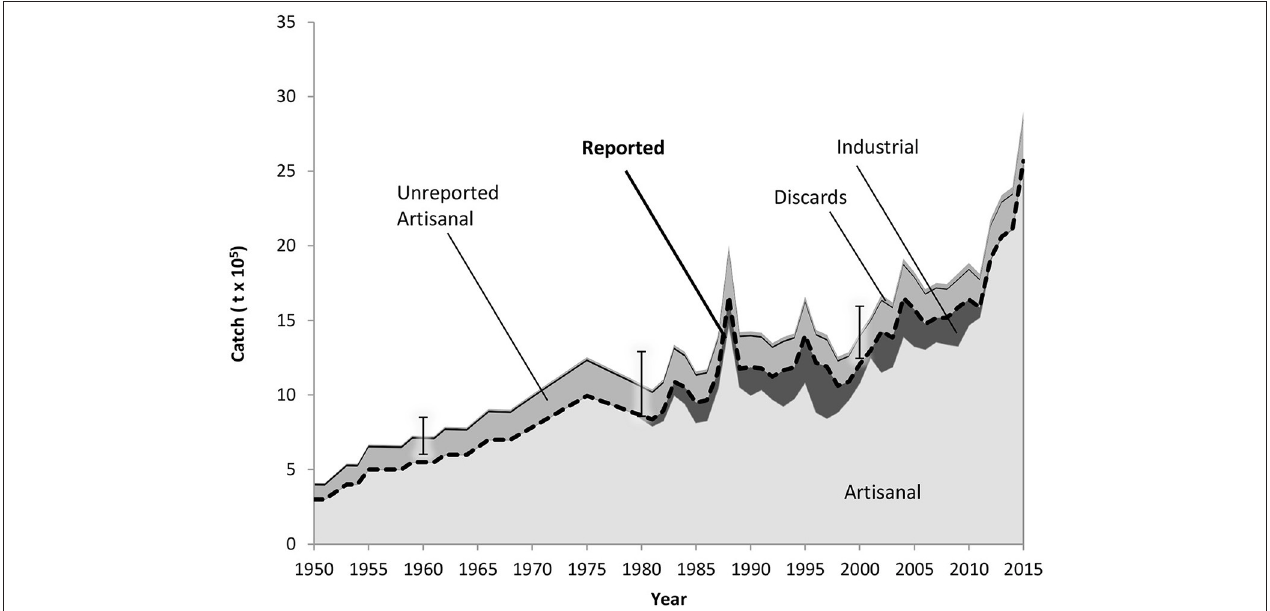
FIGURE 4 | Reconstructed catches for all Oman (including Musandam), 1950-2015, by sector, with discards shown separately, and adjusted reported landings overlaid as a dashed line graph. Subsistence and recreational catches are included, but are too small to be visible. Uncertainty bars are displayed for the periods 1950-1969, 1970-1989,